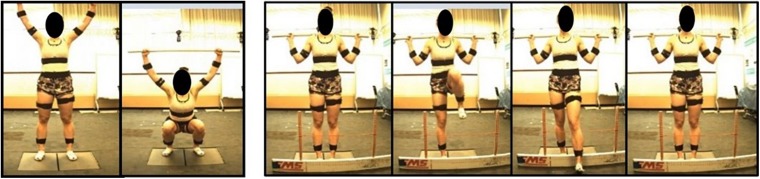
Deep squat movement and hurdle step movement as adapted from Cook et al. (2006a).